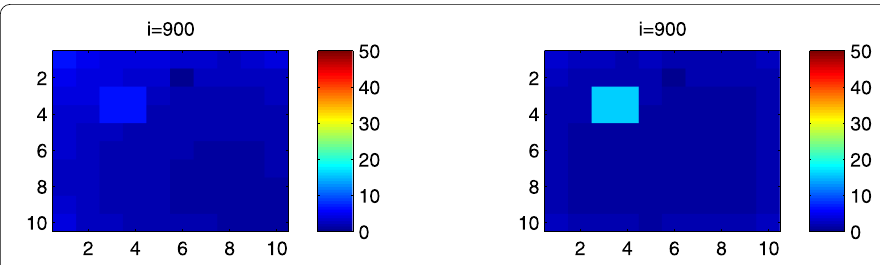
Figure 15 I Cpq behavior at the final instant i = 900 in the presence of optimal controls characterized in (11) with a travel-blocking vicinity optimal control strategy followed in the two patches P and P (cid:2) = { C 26 } . On the left side, the case when the disease starts from the corner cell C 1010 . On the right side, the case when the disease starts near the center of (cid:2) , exactly at C 65 .